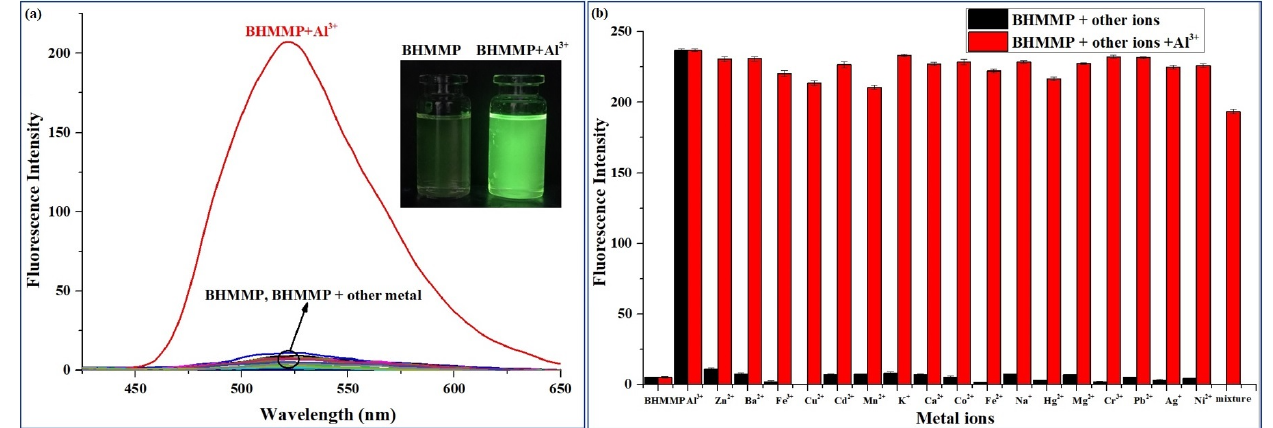
Figure 1. ( a ) Fluorescence spectrum changes of BHMMP (10 µM) in EtOH/H 2 O (2/3, v / v , 0.01 M HEPES, pH = 5) after adding different metal ions (50 µM), λ ex = 370 nm. Inset: visual fluorescence change of BHMMP solution upon addition of Al 3+ under UV illumination at 365 nm. ( b ) The emission intensity of BHMMP (10 µM) solution containing Al 3+ (50 µM), as well as the same amount of interfering ions at 522 nm.